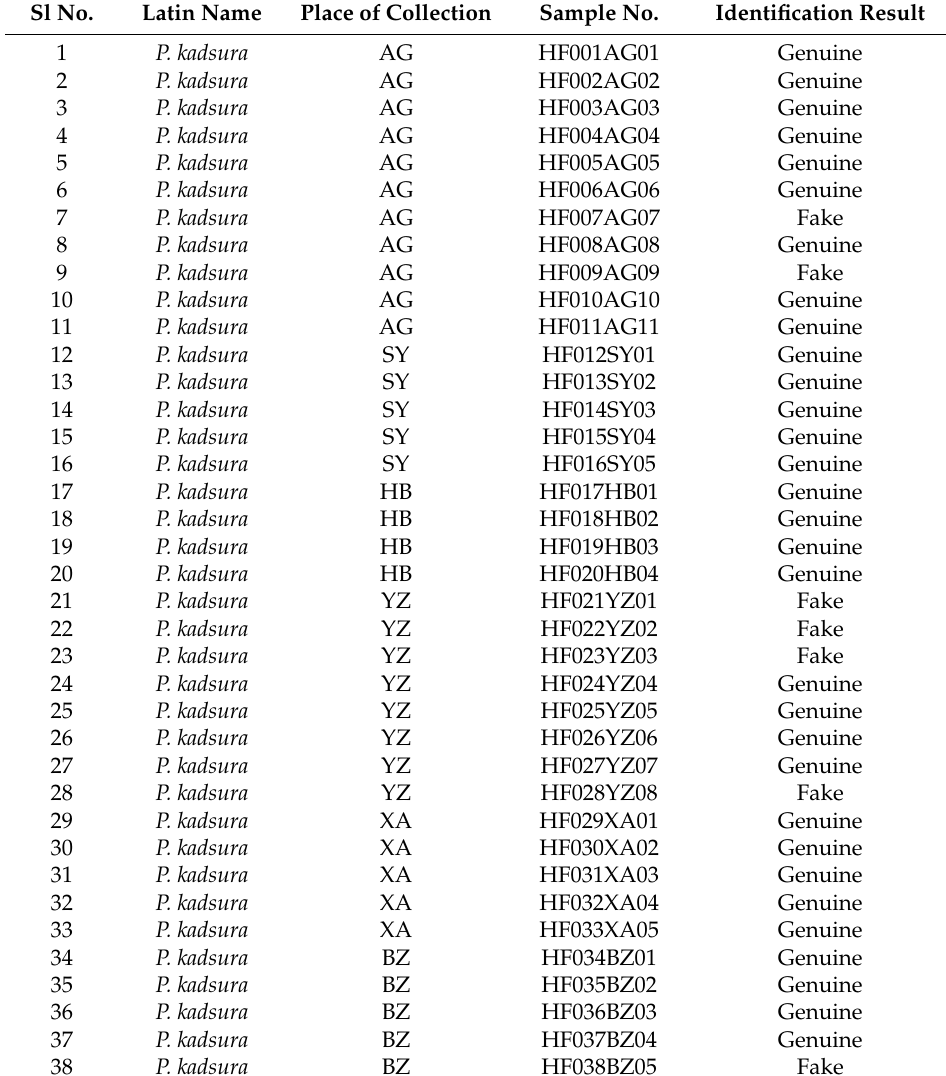
Table 2. The list of 38 samples used in this study. AG: Hebei Anguo; BZ: Anhui Bozhou; HB: Heilongjiang Haerbin; SY: Hunan Shaoyang; XA: Shanxi Xian; YZ: Henan Yuzhou. Sl No.